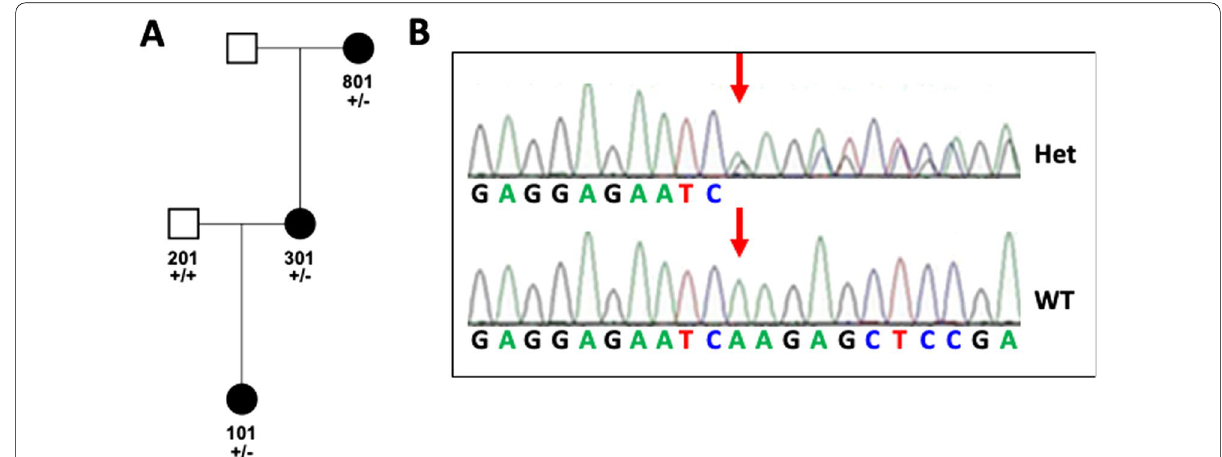
Fig. 2 Representation of electropherograms and pedigree of the family S318. A Pedigree and segregation of the IKBKG variant in the family. B Shows electropherograms of the p. Q59Rfs*78 variant. Het: heterozygous mutant, WT: wild